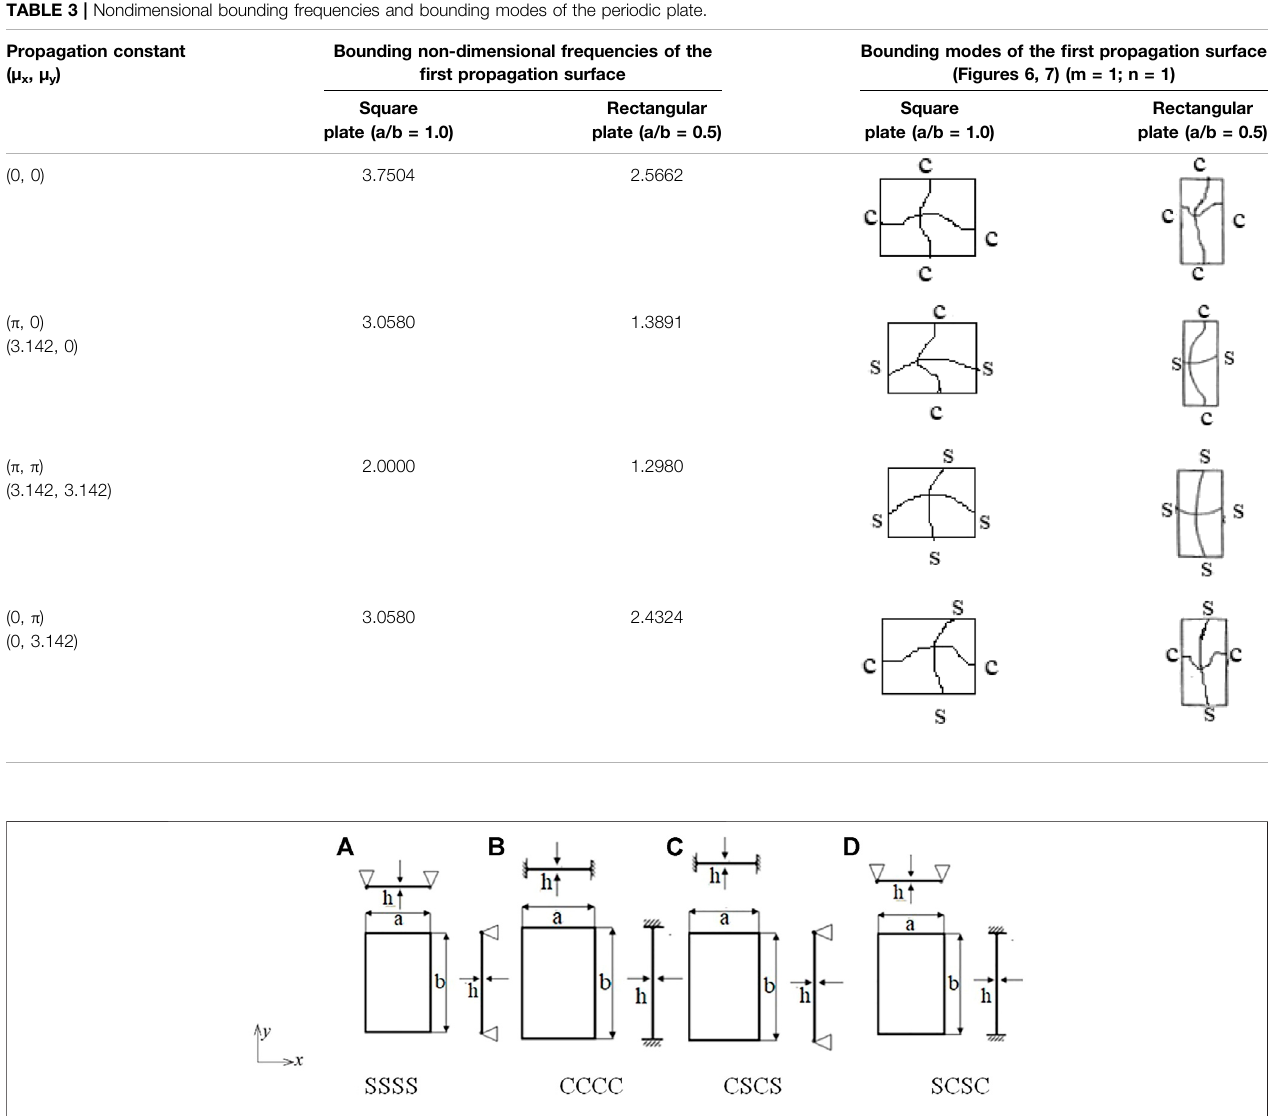
Frontiers in Mechanical Engineering |